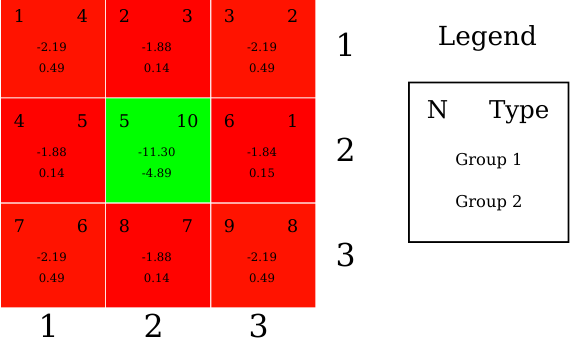
Figure 4. 2D flux differences for each part of the test case in CASE3 and enrichment